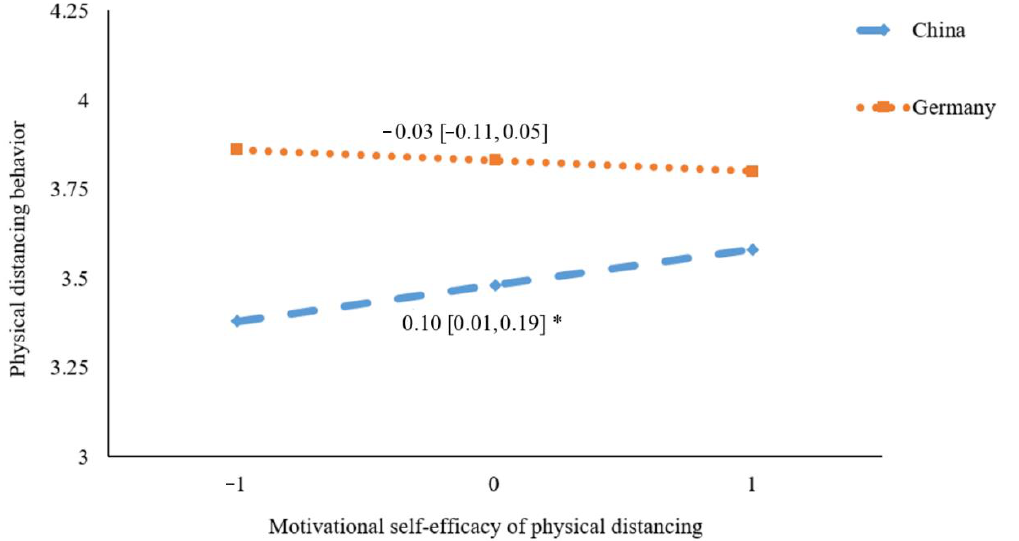
Figure 3. Plot of simple slopes showing the association between motivational self-efficacy and physical distancing at different countries ( n = 578); * p < 0.05.